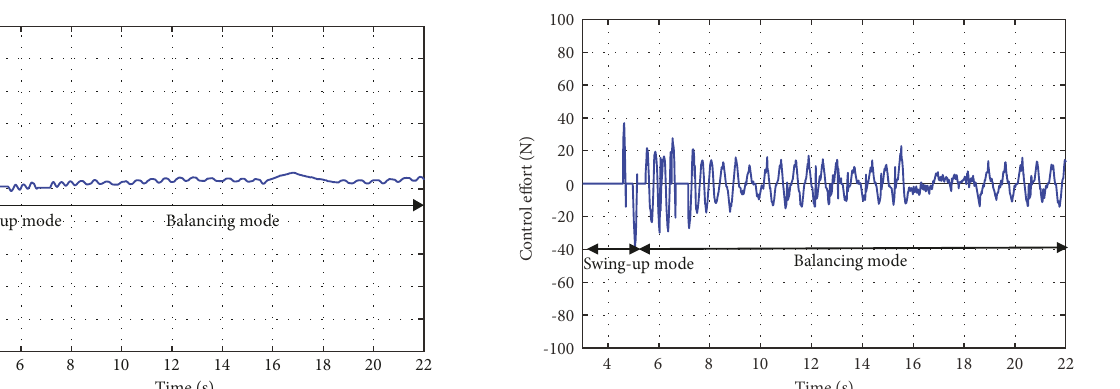
Figure 19: Control effort based on the suggested fuzzy-PID